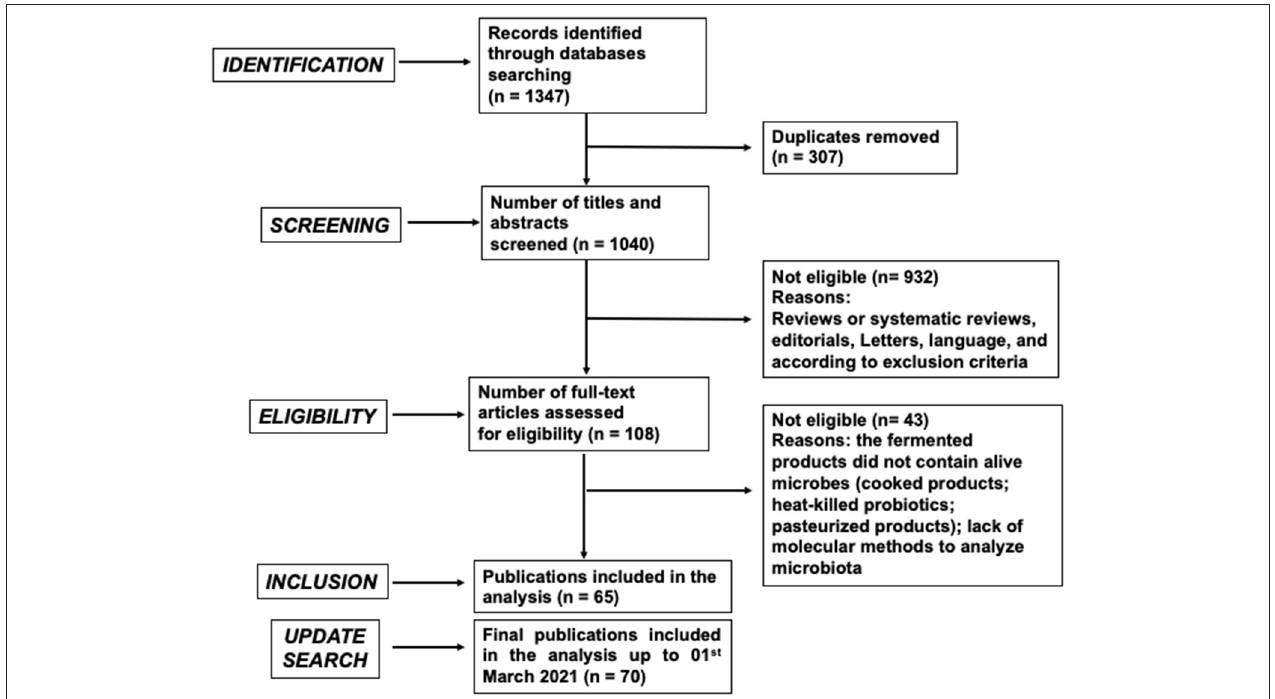
FIGURE 1 | PRISMA flow chart diagram of screening and selection processes applied to identify research articles included in the analysis. Exclusion criteria were the following: Animal or cellular studies; supplementation with encapsulated/lyophilized probiotics; supplementation with probiotics carried by a non-fermented food matrix; supplementation with fermented products that did not contain live microbes, such as cooked or pasteurized products (tea/coffee, fermented pasta, bread and bakery products, alcoholic beverages), heat-killed or UV-killed probiotics; supplementation exclusively with prebiotics or bioactive molecules; analysis of gut microbiota assessed only by cultural methods (unless the selected articles provided significant results in terms of colonization of ingested bacterial strains); analysis of gut microbiota indirectly deduced by the detection of microbial metabolites.